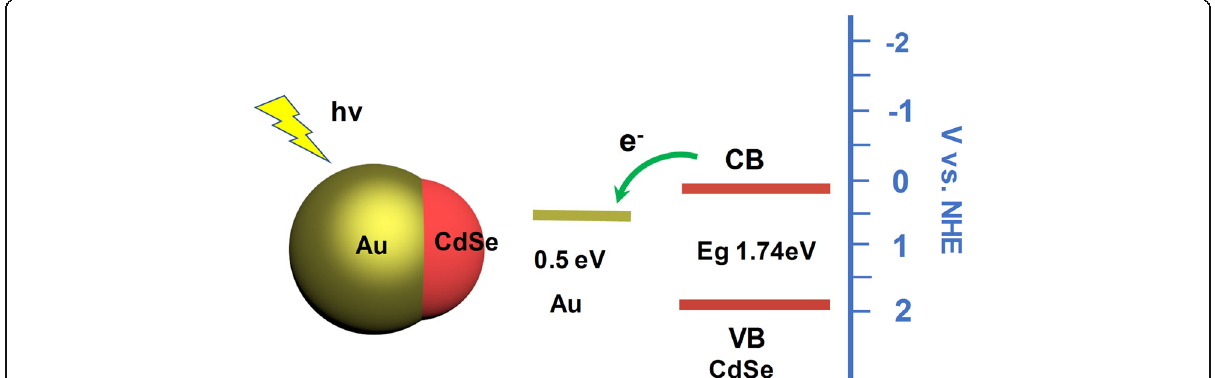
Fig. 8 Schematic illustration of the charge separation at the interface of Au/CdSe